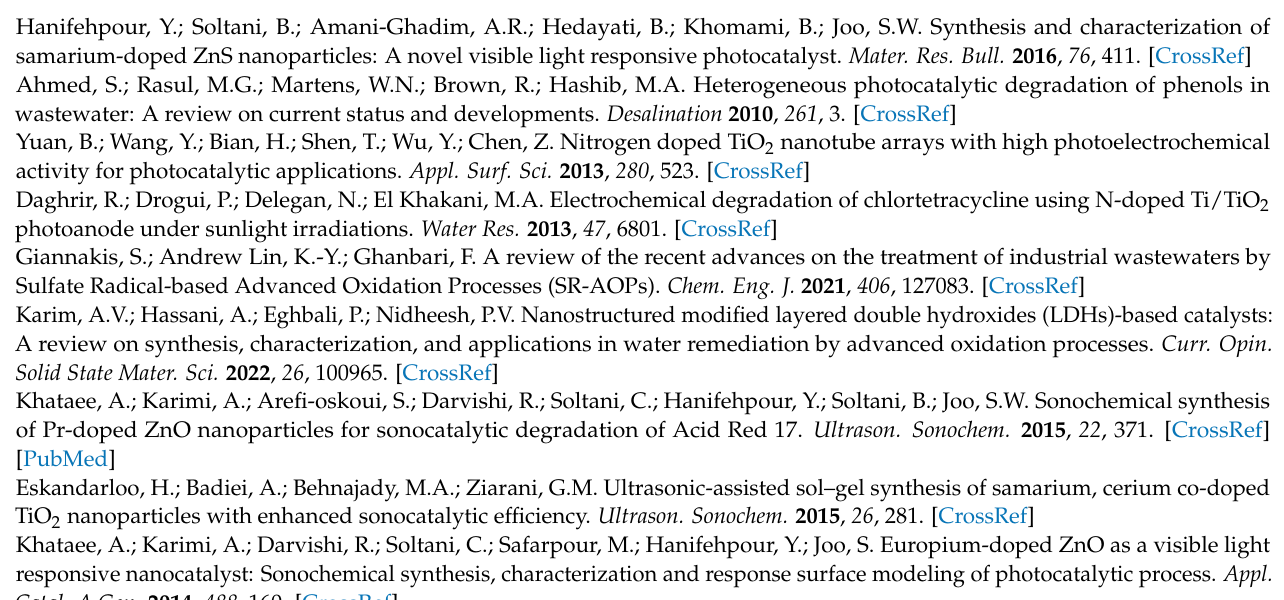
8% Eu-doped Y 2 O 3 coated biosilica; Figure S4: TEM image of 2% Eu-doped Y 2 O 3 -coated diatomite; Figure S5: TEM image of 8% Eu-doped Y 2 O 3 -coated diatomite; Figure S6: EDX spectra of 2% Eu- doped Y 2 O 3 -coated diatomite; Figure S7: EDX spectra of 2% Eu-doped Y 2 O 3 -coated diatomite; Figure S8: Schematic band-gap model for the luminescence of Eu 3+ doped in Y 2 O 3